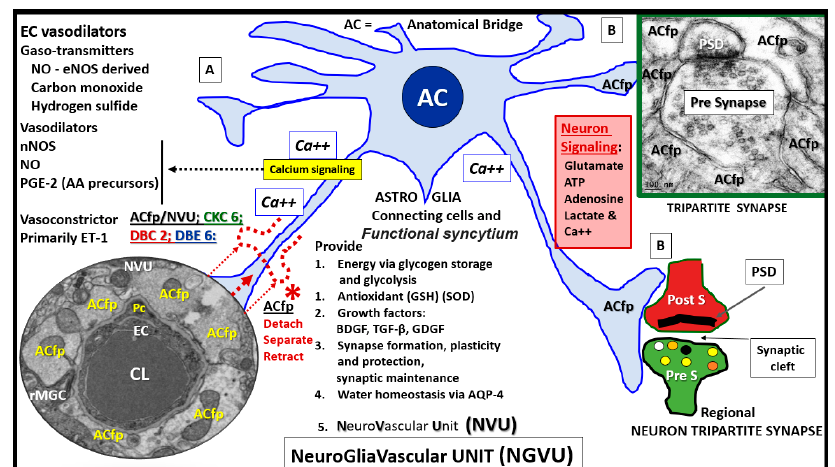
Figure 5. The astrocyte connectivity between the capillary and neurons to form the neurovascular unit: This image illustrates the combination of cartoon and transmission electron micrographs (TEM). ( A and B ) The importance of astrocyte (AC) connections via their end-feet foot processes (ACfp): The connection between the cerebral capillary neurovascular unit (NVU-magnification ×4000) and astrocyte (AC-ACfp) reside at each end of the AC colored light blue. Note that Figure 5A is the capillary NVU to the left and that the tripartite neuronal synapse on the right is Figure 5B. Note the detachment separation and retraction of the ACfp (red dashed lines) in Figure 5A. Note the red and green colorized pre- and post-synapse and the synaptic cleft (20 nm) and its relation to the connecting